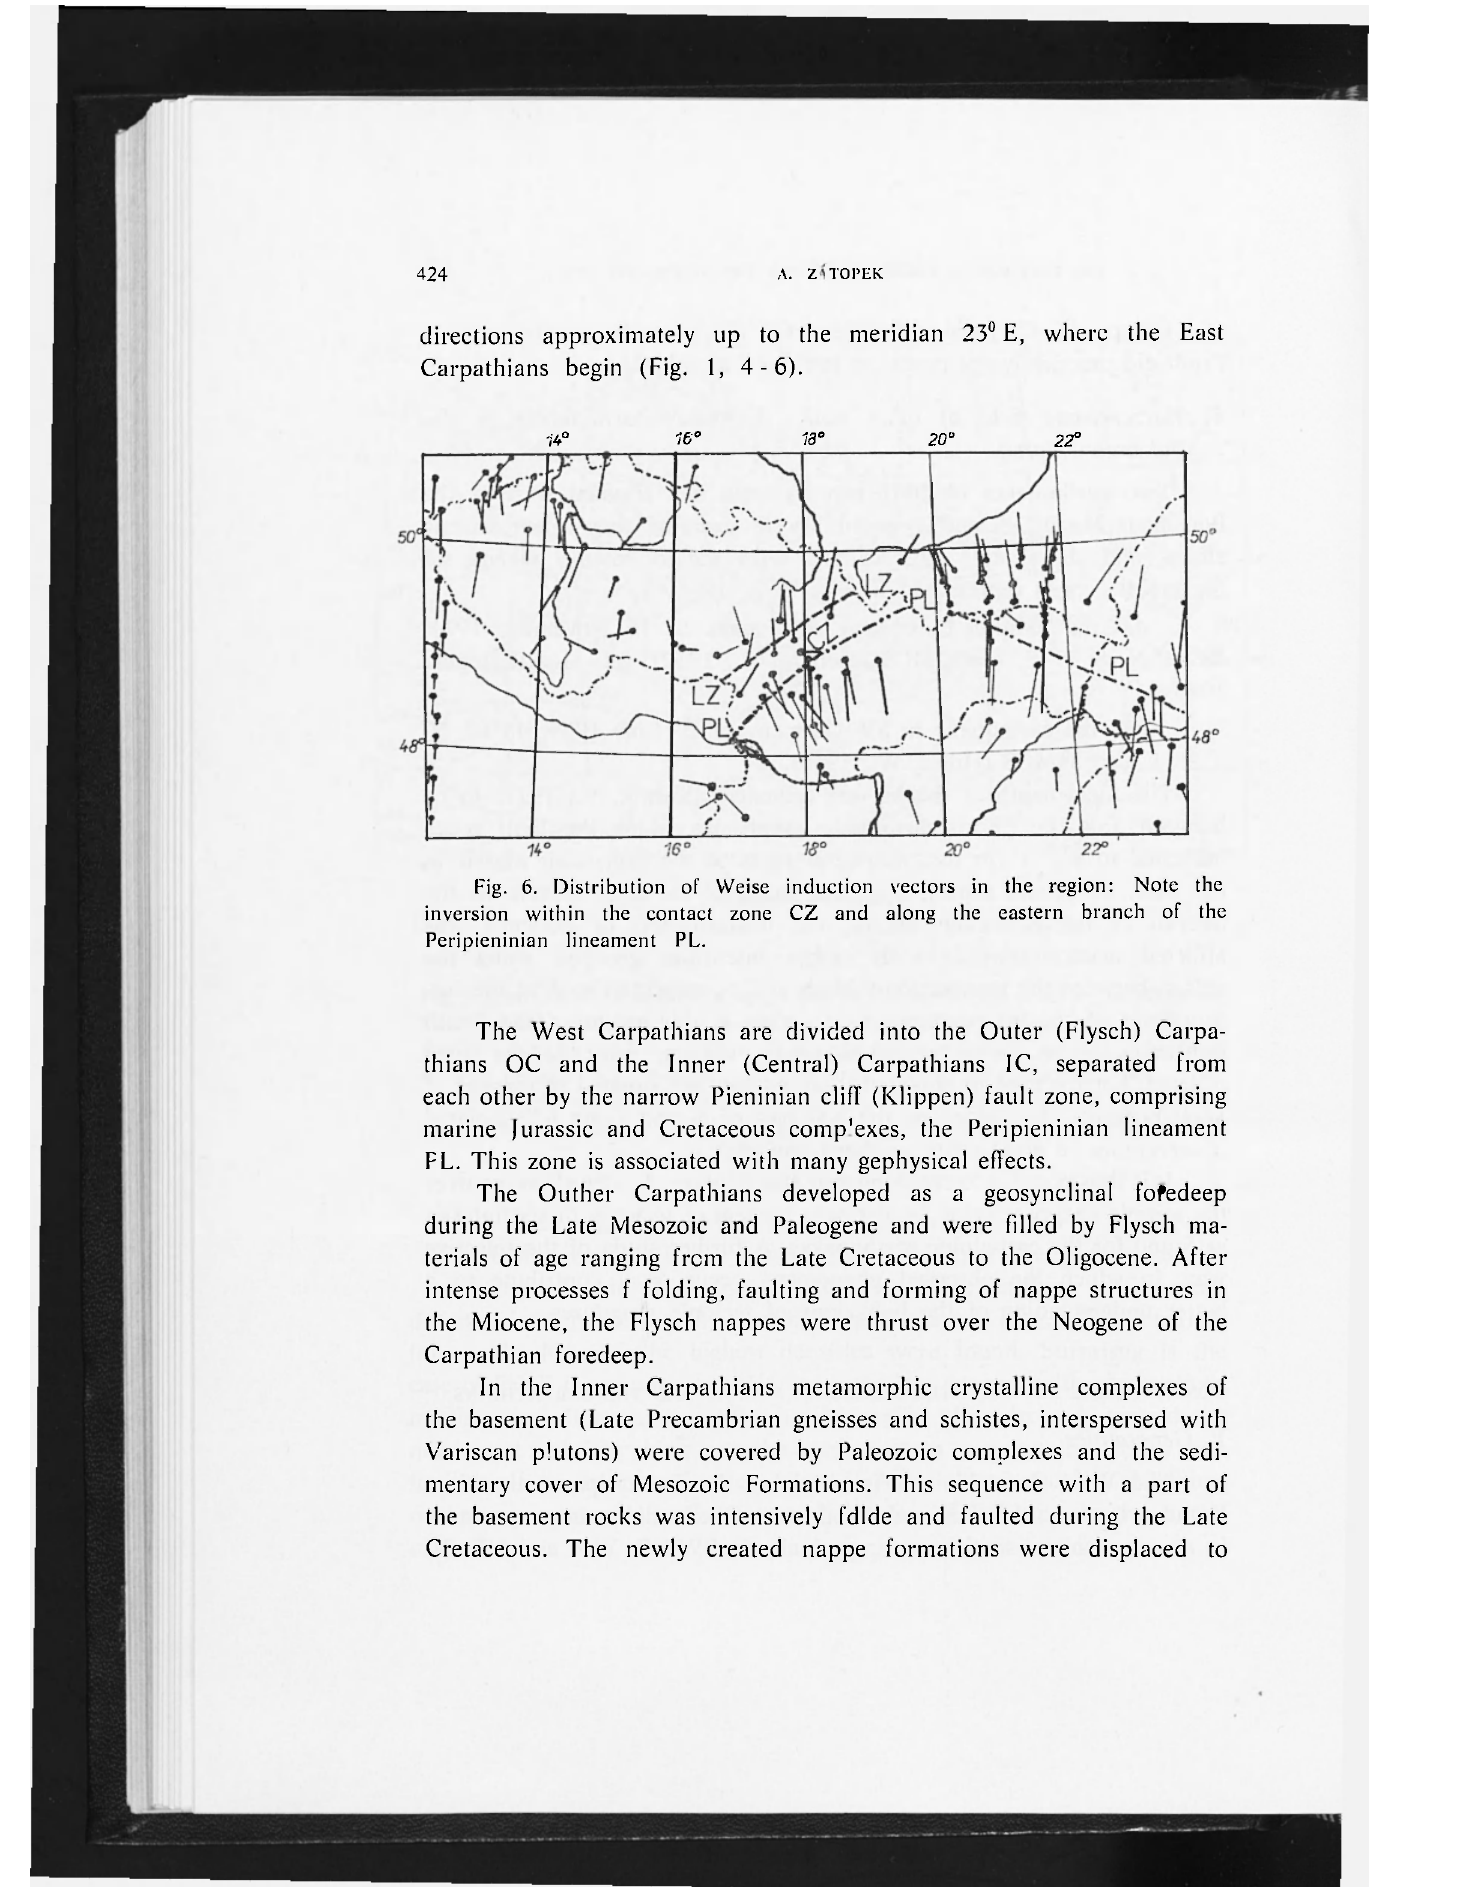
Fig. 6. Distribution of VVeise induction vectors in the region: Note the inversion within the contact zone CZ and along the eastern branch of the Peripieninian lineament